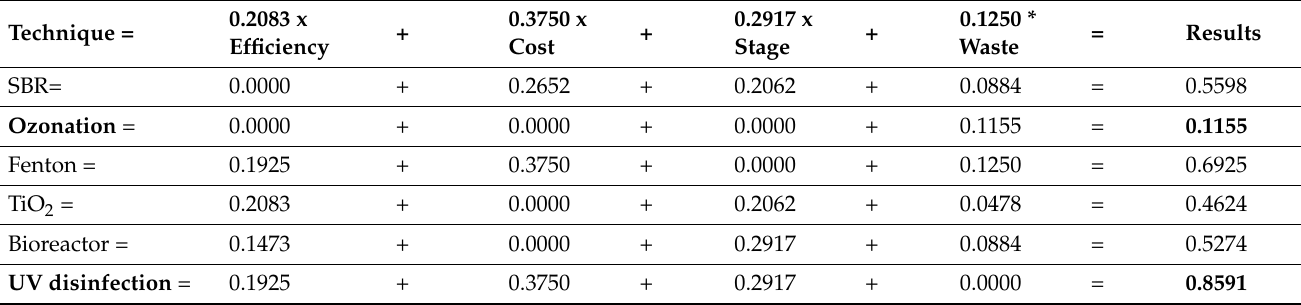
Table 4. Results applying the Modified Saaty